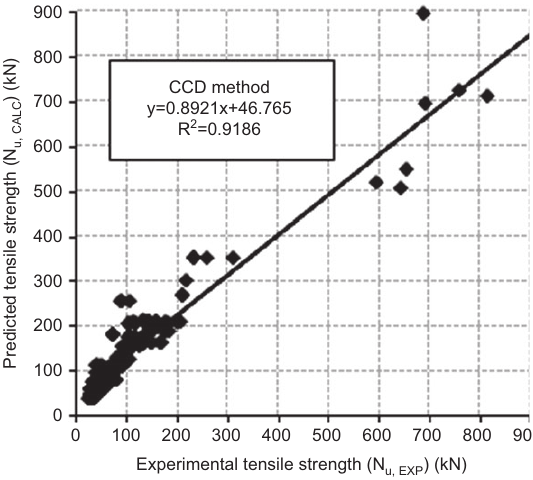
Figure 9 CCD method calculation results for group anchors.